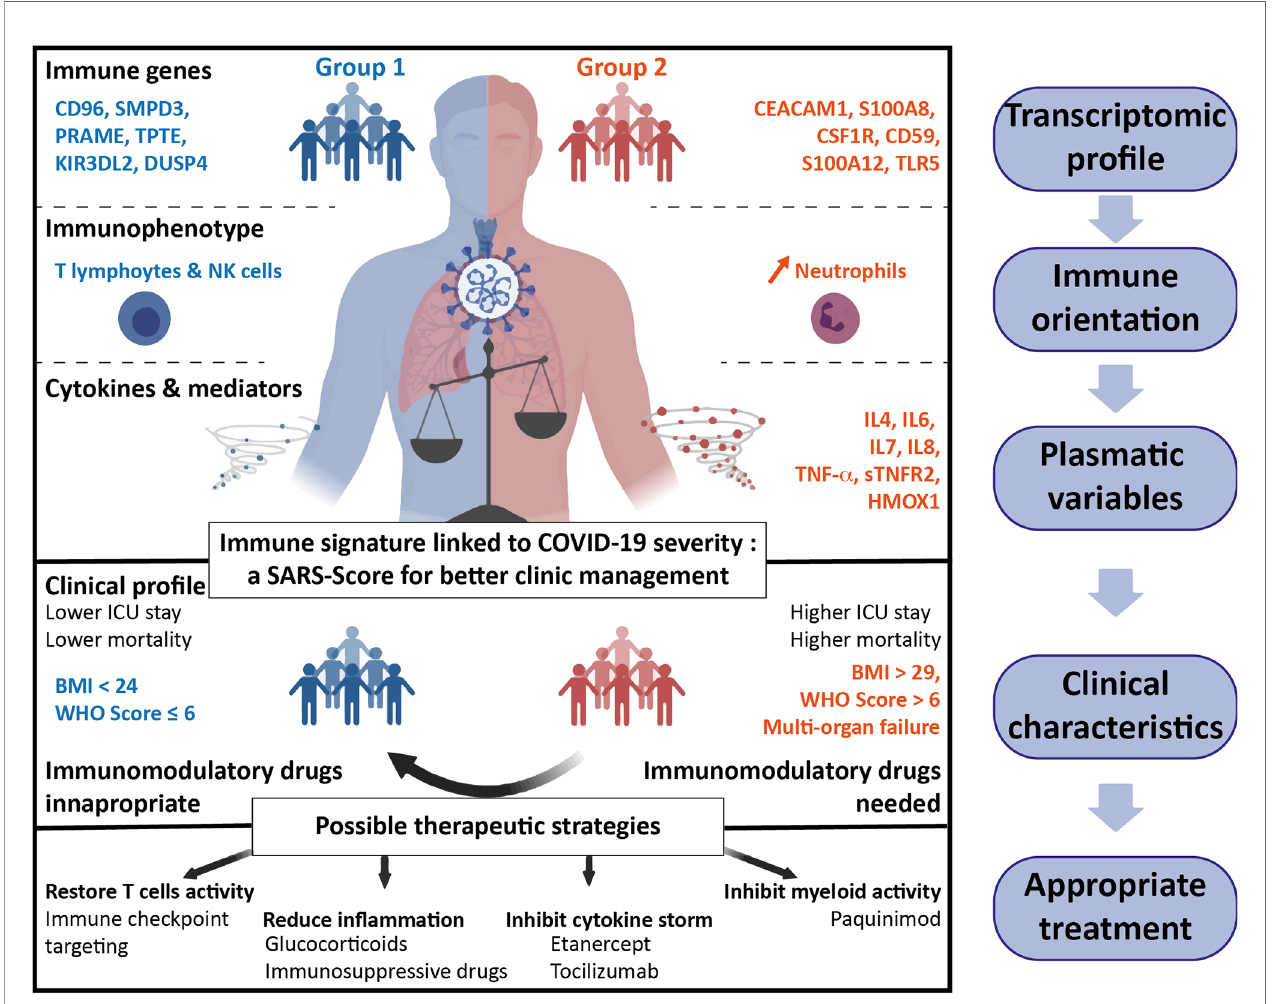
FIGURE 6 | Summary of the two groups of hospitalized COVID-19 patients. Groups 1 (blue, left part) and 2 (red, right part) have been de fi ned on differential immune transcriptomic pro fi les that correspond to speci fi c immune orientations. The plasmatic and clinical characteristics of these two groups allow to predictively classify the patients and personalize the therapeutic strategies to improve the outcome of COVID-19